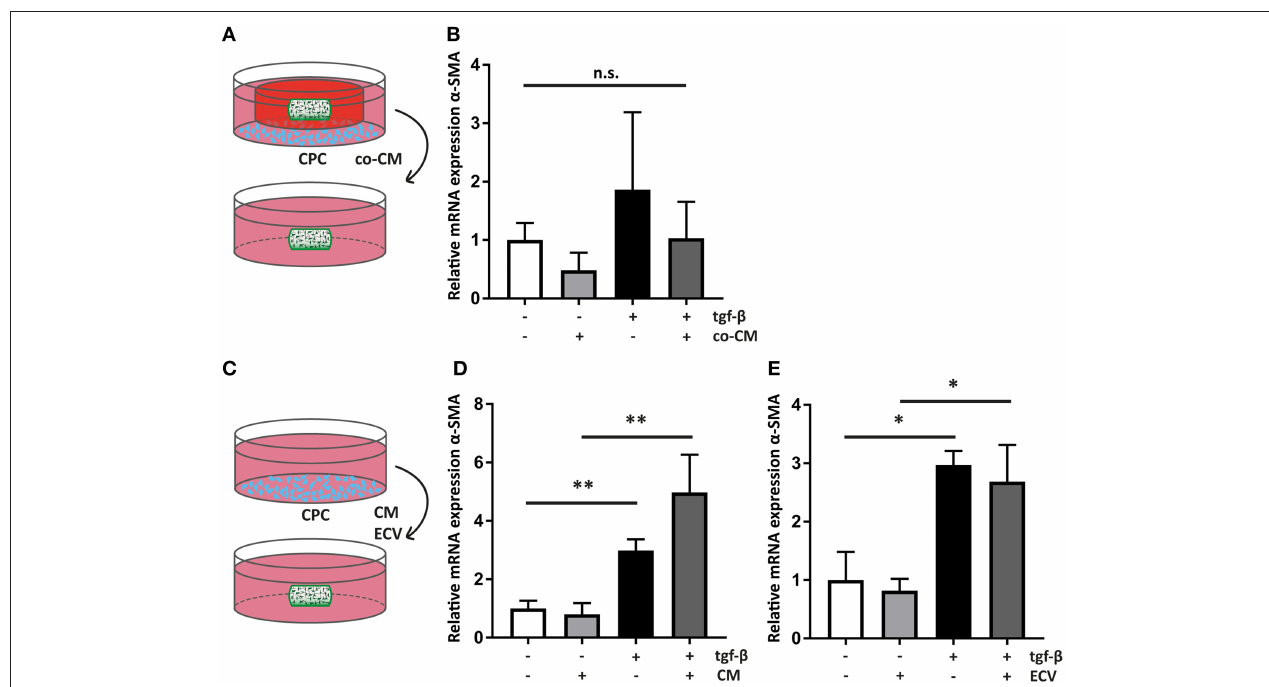
FIGURE 5 | Cardiac progenitor cells act via paracrine mediators. (A) Schematic overview of the experimental set-up of transfer of co-CM to a naïve hfCF-laden hydrogel. (B) co-CM attenuates α -SMA expression in hfCF-laden GelMA in culture conditions with or without 2ng/ml TGF- β 1 ( n = 5). Statistical significance was assessed using repeated measures two-way ANOVA. (C) Schematic overview of the experimental set-up of treatment of naïve hfCF-laden hydrogels with CPC conditioned medium (CM) or CPC-derived extracellular vesicles (EV). (D) CM does not influence hfCF activation. In pro-fibrotic medium the expression of α -SMA is significantly increased ( n = 8). Statistical significance was assessed using repeated measures two-way ANOVA. ** p < 0.01. (E) Isolated EV show similar effects as CM ( n = 3). Statistical significance was assessed using repeated measures two-way ANOVA. * p <